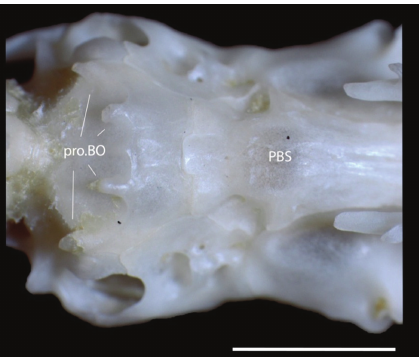
Figure 10: Posteroventral view of the skull of Sordellina punctata (IBSP46054). Bar = 3mm. Abbreviations other than in previous figures are pro.BO: dentigerous processes of basioccipital.